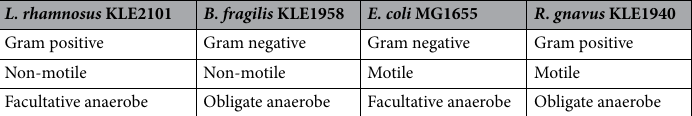
Table 1. Summary of bacterial characteristics by species 36,50,51,54